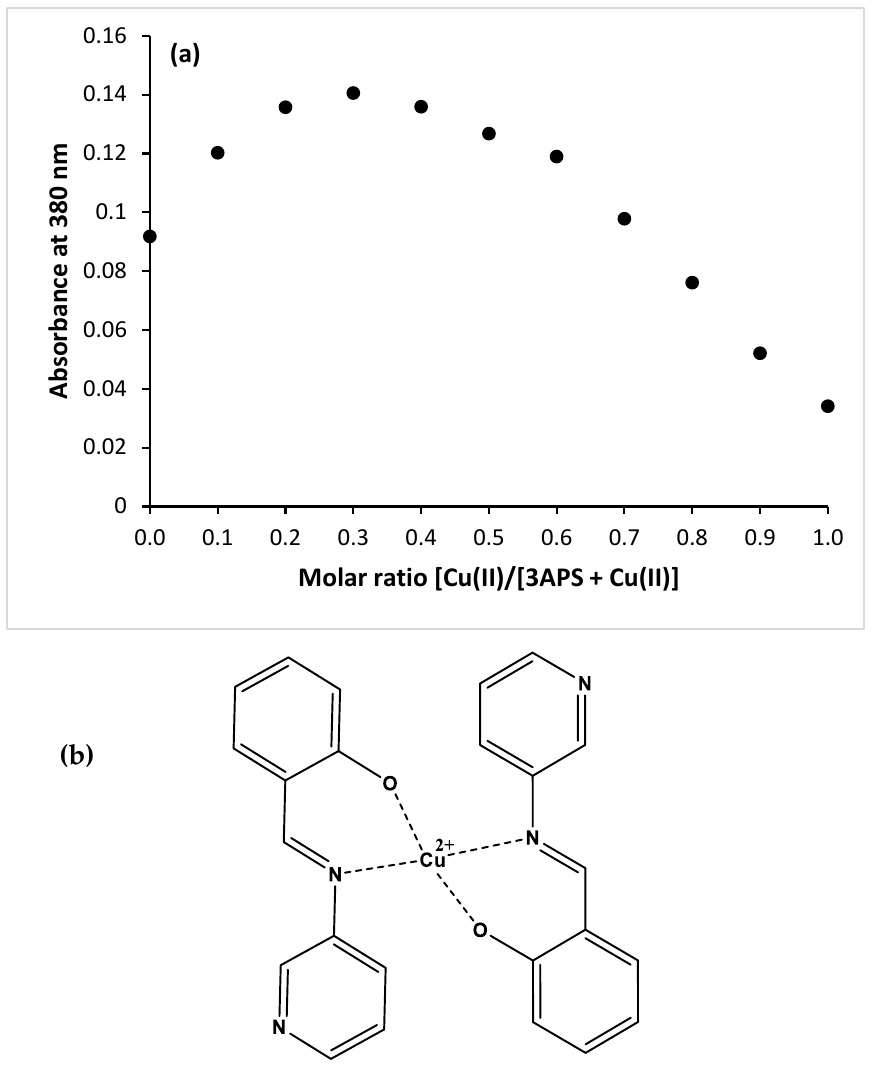
Figure 5. Job’s plot for the 3APS–Cu(III) interaction at 385 nm ( a ). The possible structure of the 3APS–Cu(II) complex ( b ).